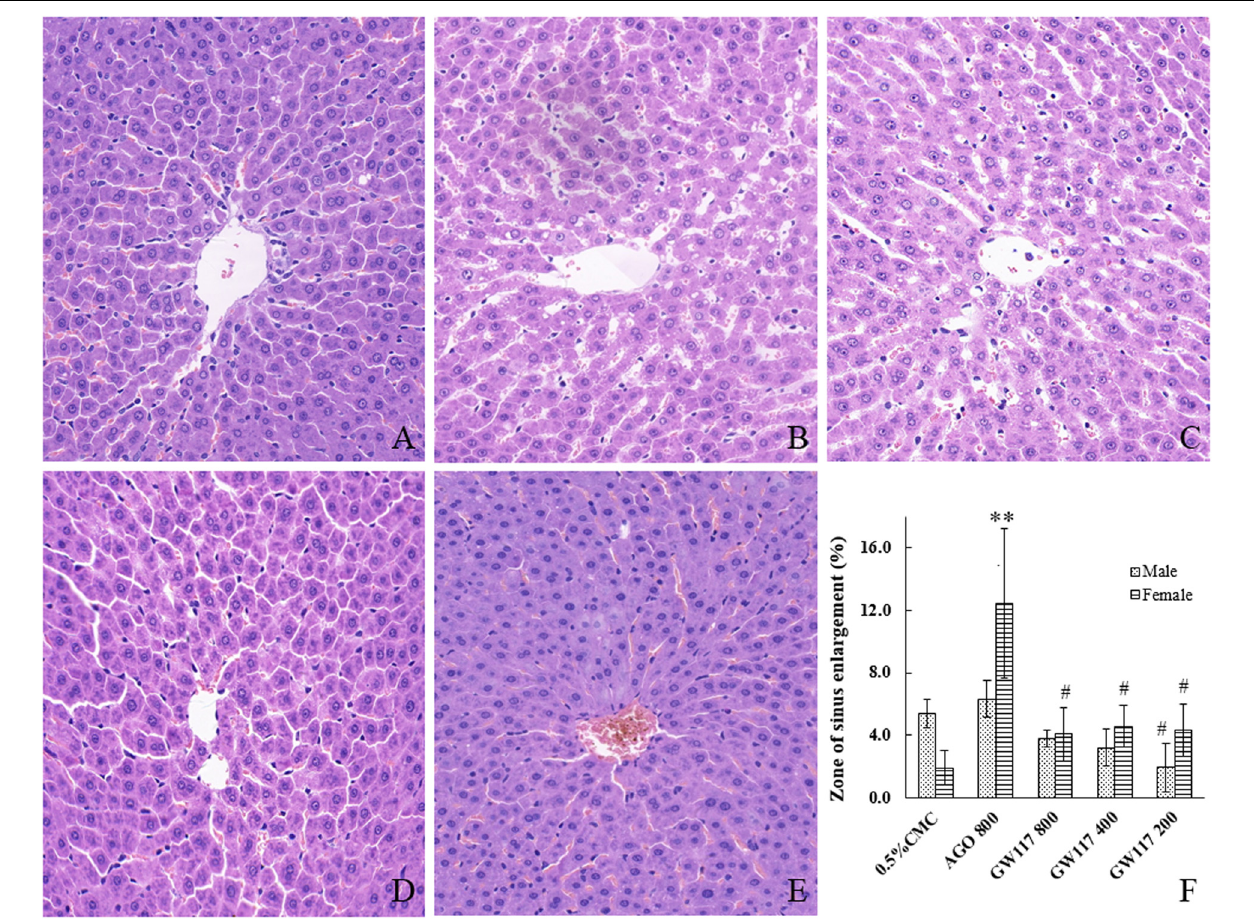
FIGURE 5 | Effects of AGO and GW117 on the histopathological changes of the liver in rats. (A) 0.5% CMC; (B) AGO 800 mg/kg; (C) GW117 800 mg/kg; (D) GW117 400 mg/kg; (E) GW117 200 mg/kg; (F) zone of liver sinus enlargement vs. 0.5% CMC group, ∗ p < 0.05, ∗∗ p < 0.01; vs. the AGO group, # p < 0.05 ( n =